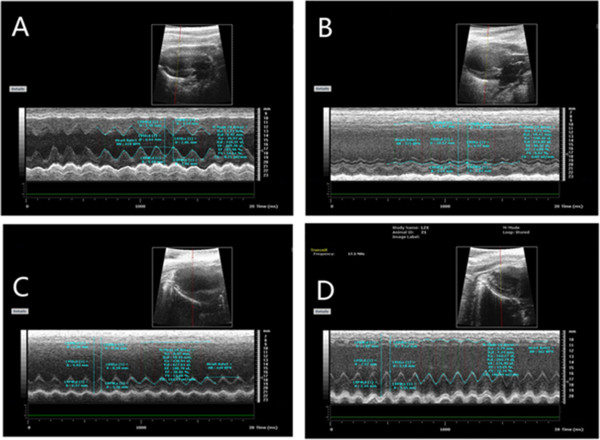
Echocardiography of rats in the control group (A), AMI group (B), PGF group (C) and PGF-PLGA
NPs
group (D) at the end of the fourth week after AMI surgery.